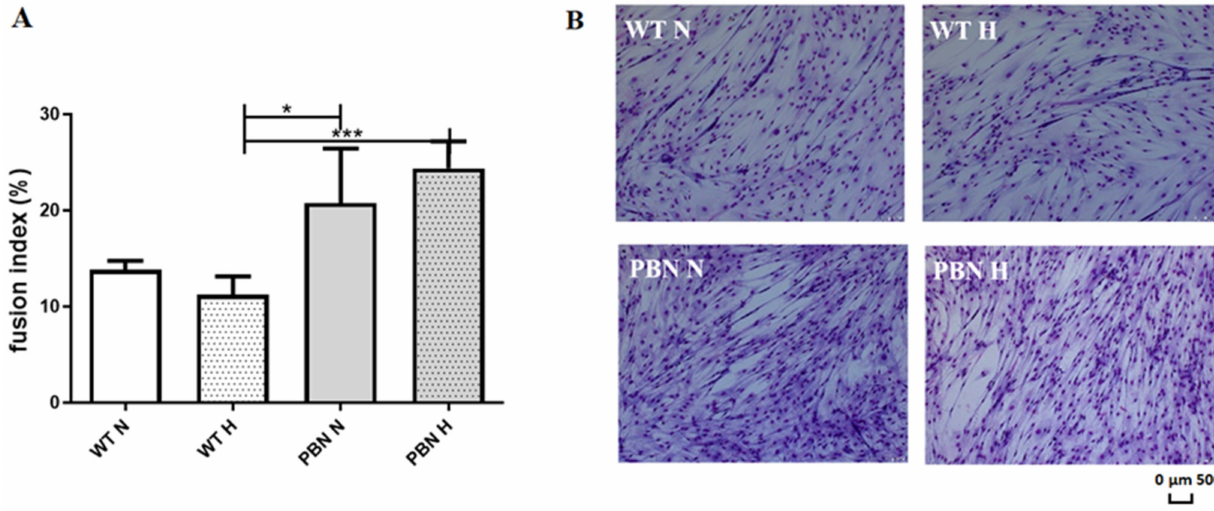
Figure 2. Percentages of fused nuclei in SkMDS/PCs-originated myotubes from the WT and PBN-treated in vitro cell culture shown as diagrams ( A ). SkMDS/PC fusion observed under a light microscope ( B ). Abbreviations: WT = wild-type non-treated SkMDS/PCs; PBN-SkMDS/PCs = cells cultured with antioxidant under N-standard and H-hypoxic in vitro culture conditions. * significant at p value < 0.05, *** significant at p value